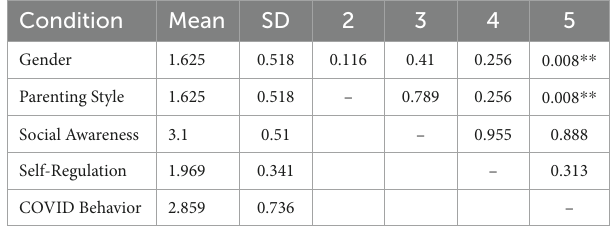
TABLE 3 Descriptive statistics and correlation coefficients for other Race-Identifying